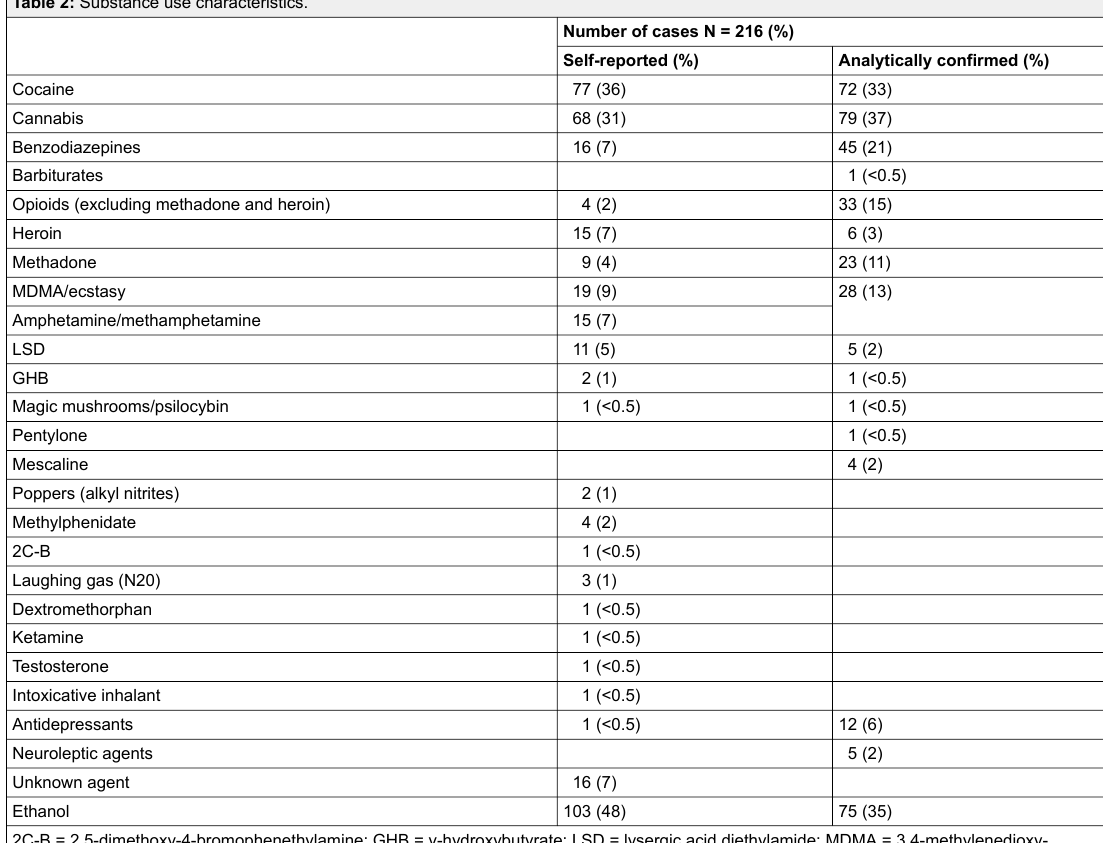
Table 2: Substance use